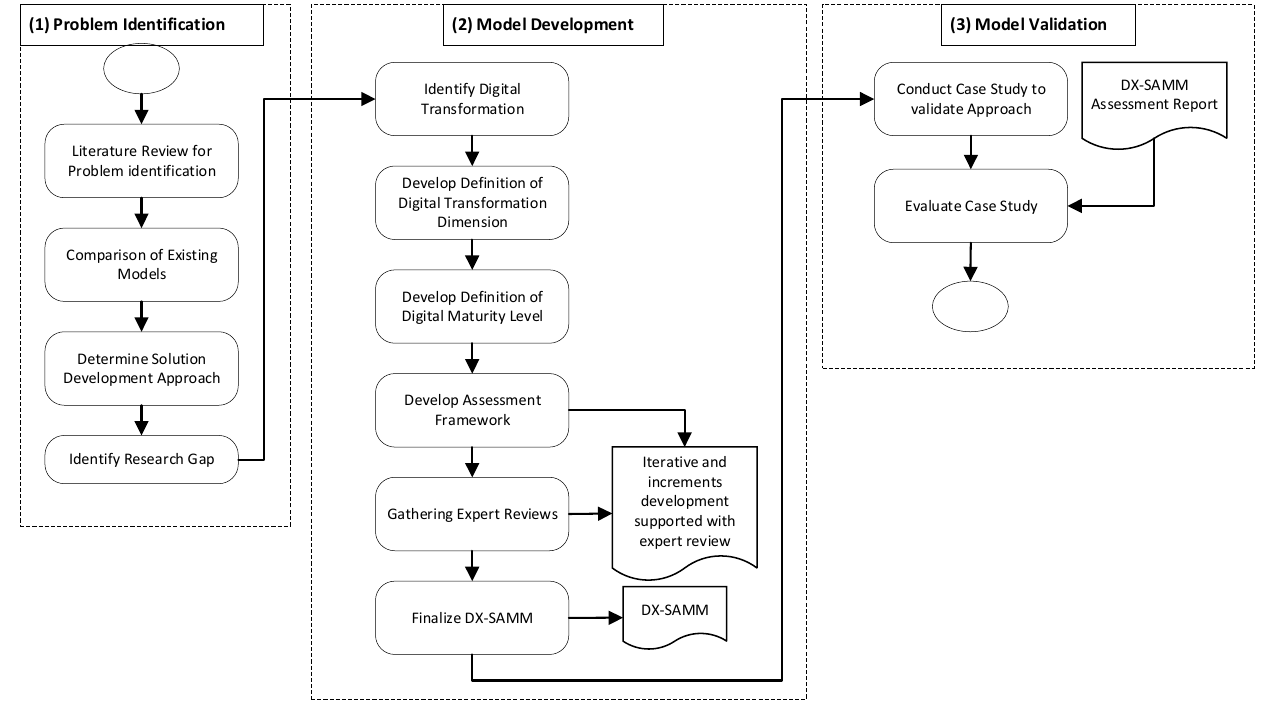
Figure 1. Stages of the Research Method.